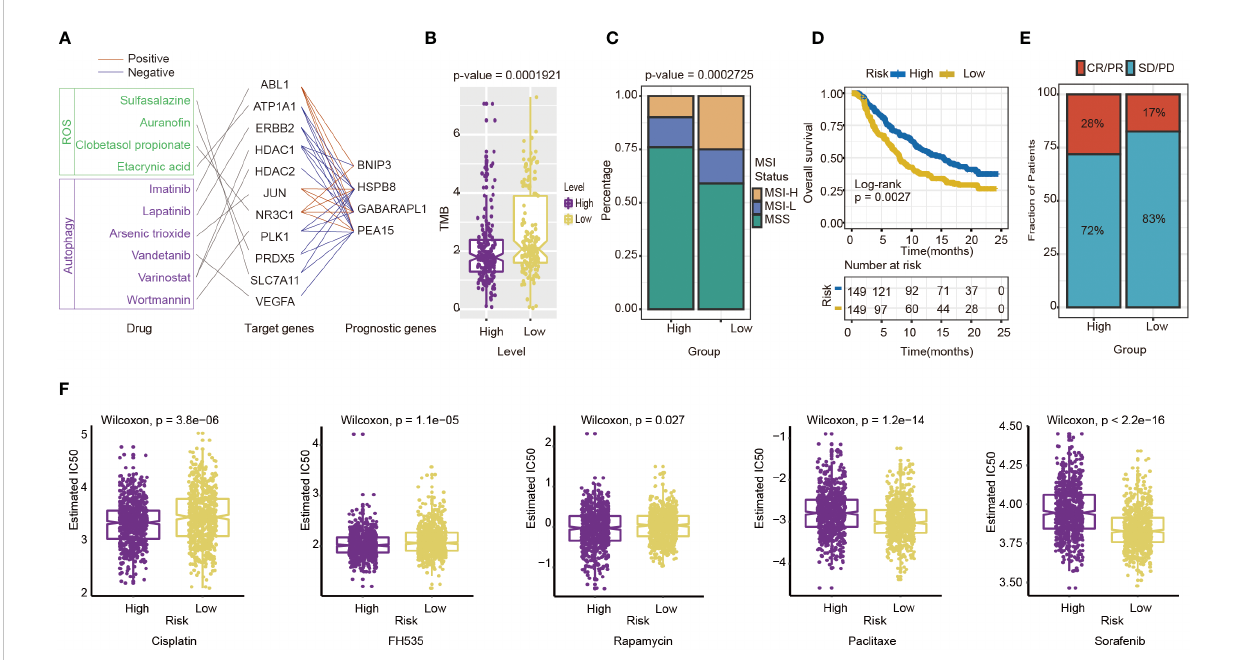
FIGURE 8 Evaluation of the potential Immunotherapy bene fi t and prediction chemotherapy sensitivity of different risk groups. (A) The interactions between drugs, drug targets and prognostic autophagy-related genes. (B) The association between risk score and TMB. (C) MSI status differences between high-and low-risk groups. MSI, microsatellite instability; MSI-L, low-level MSI; MSI-H, high-level MSI; MSS, stable MSI. (D) Kaplan-Meier survival curves for patients between high- and low-risk groups in IMvigor210 cohort (n=298, P= 0.0027). (E) Differences in immunotherapy response between high - and low-risk groups in IMvigor210 cohort CR/PR: response to immunotherapy SD/PD: no response to immunotherapy. (F) Chemotherapy sensitivity of different risk groups: from left to right are Cisplatin, FH535, Rapamycin, Paclitaxe and